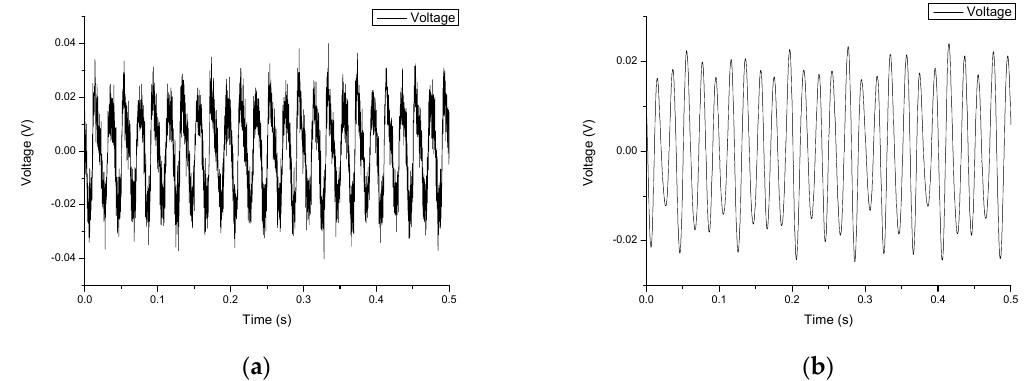
Figure 6. Original and reconstructed signal of propeller noise: ( a ) Original signal; ( b ) reconstructed signal.